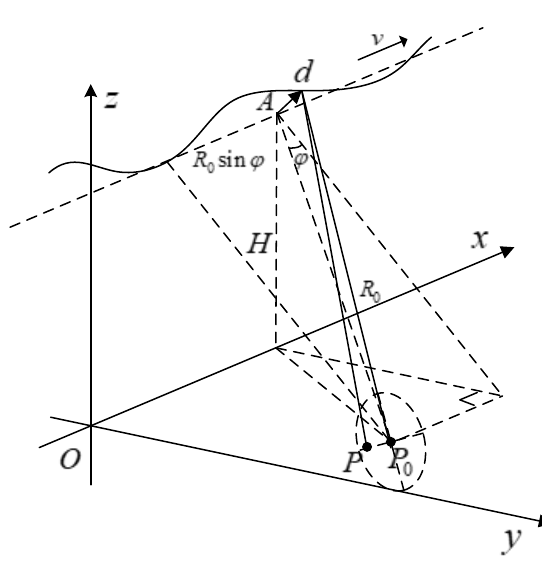
Figure 1. Radar platform motion geometry